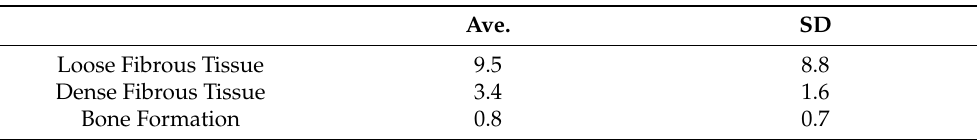
Table 1. Percentage area of scala tympani filled by fibrous tissue and bone 48 days–8 weeks after cochlear